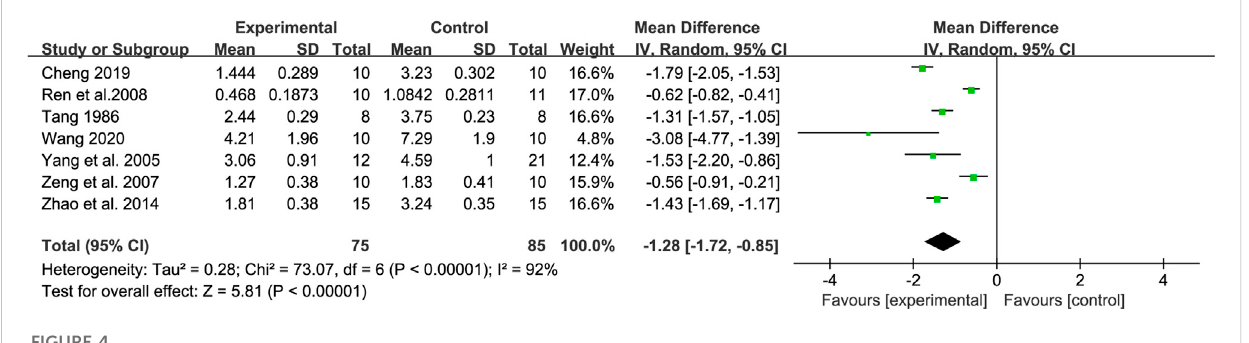
FIGURE 4 Forest map of tumor weight.